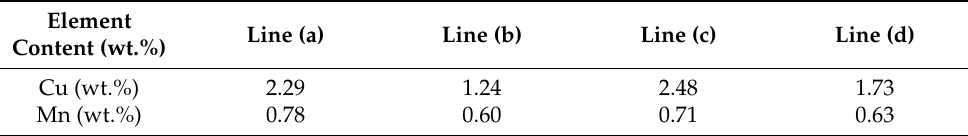
Table 1. The results of linescan in α (Al) at different positions of as-cast ACMZ and ACMZ-0.1 nanopar- ticles. Line (a): The central segregation region of ACMZ; Line (b): The surface of ACMZ; Line (c): The central segregation region of nanoparticles; Line (d): The surface of ACMZ-0.1 nanoparticles. Element Line (a) Content (wt.%)